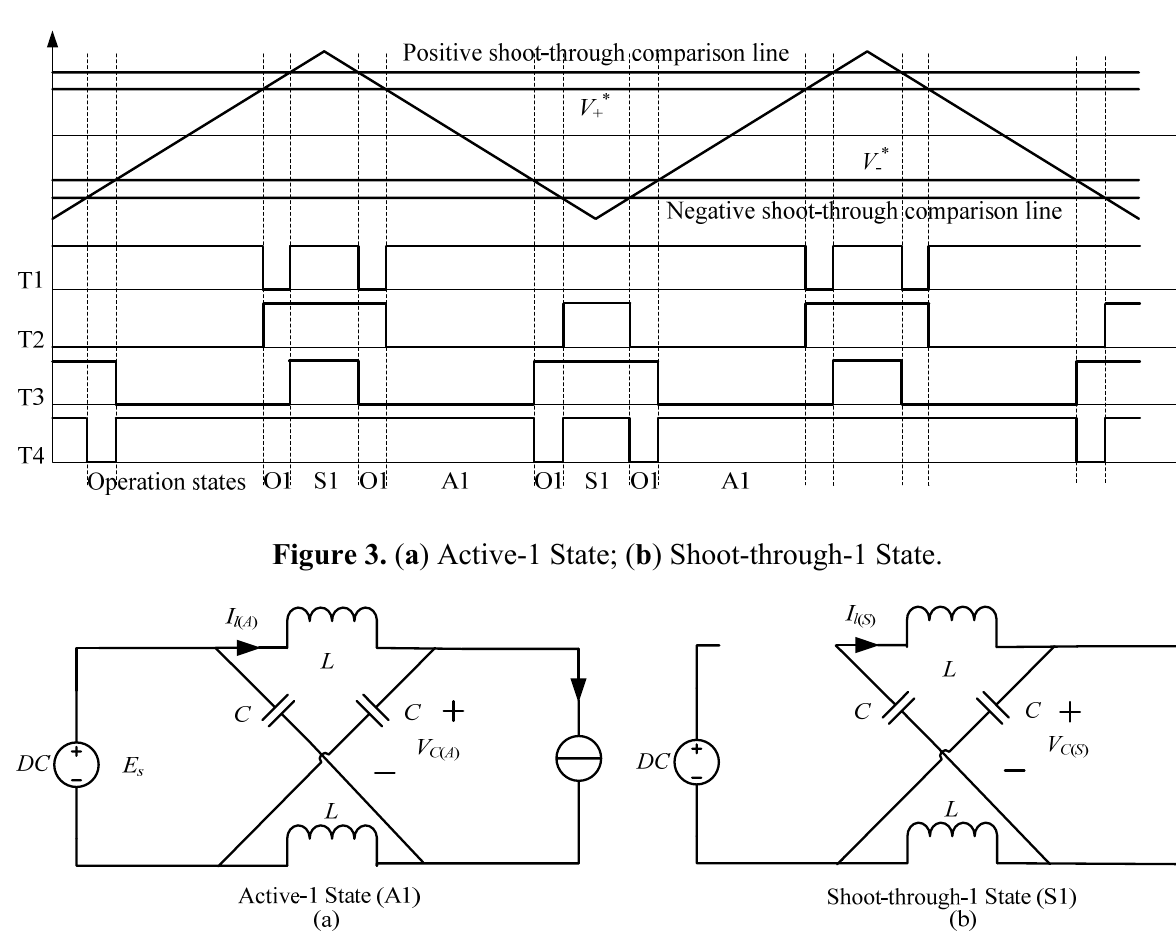
Figure 2. Simple boost control of single-phase ZSI.